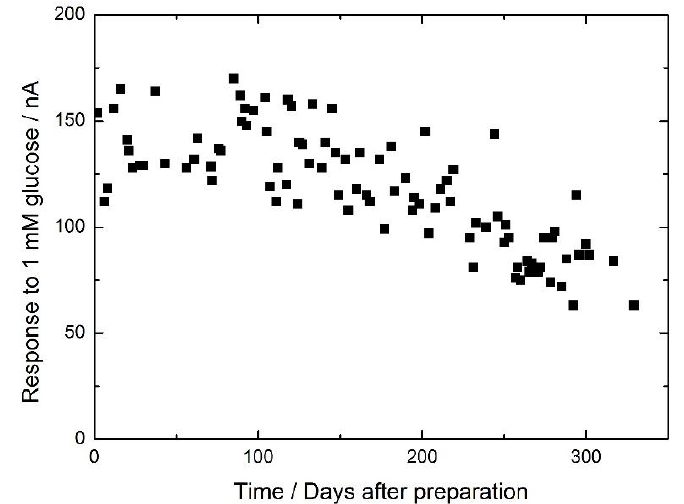
Figure 2. Long-term stability of the cellulose-based glucose oxidase (GOD) membrane. The daily response of the electrode to 1 mM glucose is